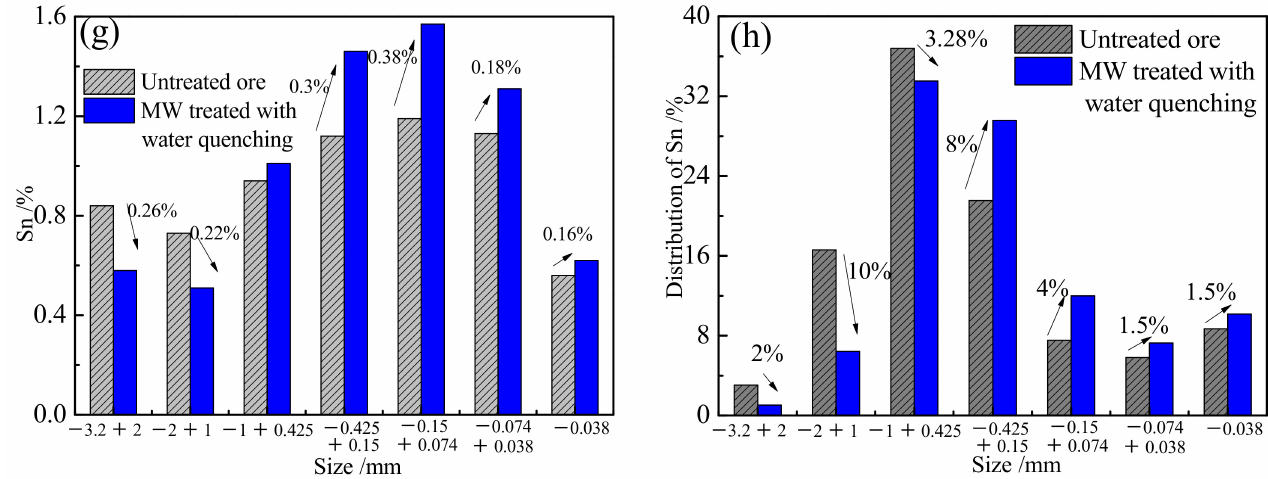
Figure 4. The grade and distribution of metal elements in each particle size range after grinding. ( a ) Fe grade, ( b ) Fe distribution, ( c ) Pb grade, ( d ) Pb distribution, ( e ) Zn grade, ( f ) Zn distribution, ( g ) Sn grade, and ( h ) Sn